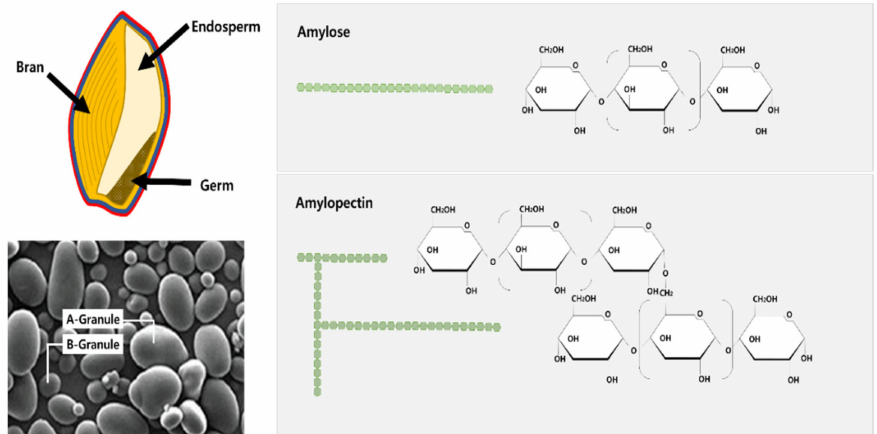
Figure 2. The main carbohydrates in wheat grain and flour: starch (amylose and amylopectin). Source: This figure was cited and edited in Shewry et al.